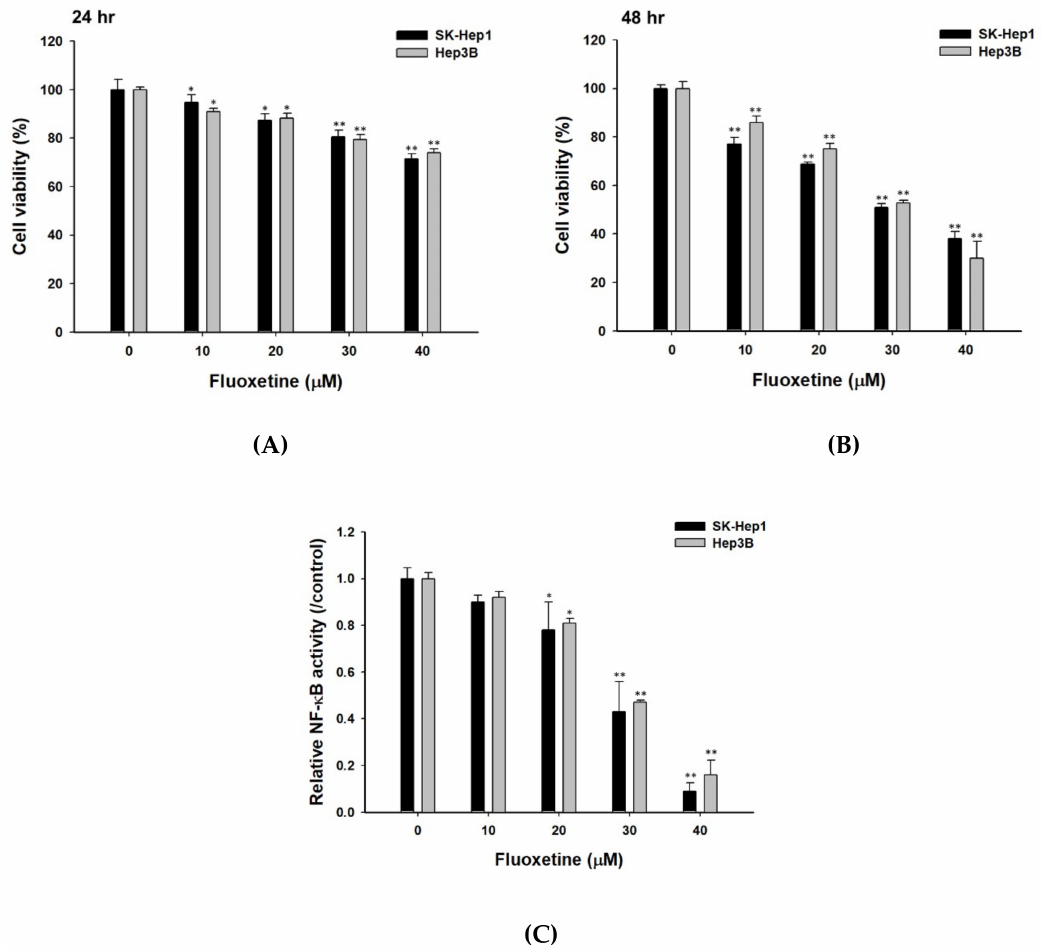
Figure 1. Fluoxetine reduced cell viability and NF- κ B activation in SK-Hep1 and Hep3B cells. Different concentrations of fluoxetine (0, 10, 20, 30, 40 µ M) were given to SK-Hep1 and Hep3B cells for 24 and 48 h and then cell viability was evaluated by MTT assay of two different hepatocellular carcinoma (HCC cells) at: ( A ) 24 h, and ( B ) 48 h. ( C ) A NF- κ B reporter gene assay was performed on SK-Hep1/ NF- κ B-luc2 and Hep3B/ NF- κ B-luc2 cells at 48 h. * p < 0.05 and ** p < 0.01, significant difference between fluoxetine-treated groups and the control as analyzed by Student’s t